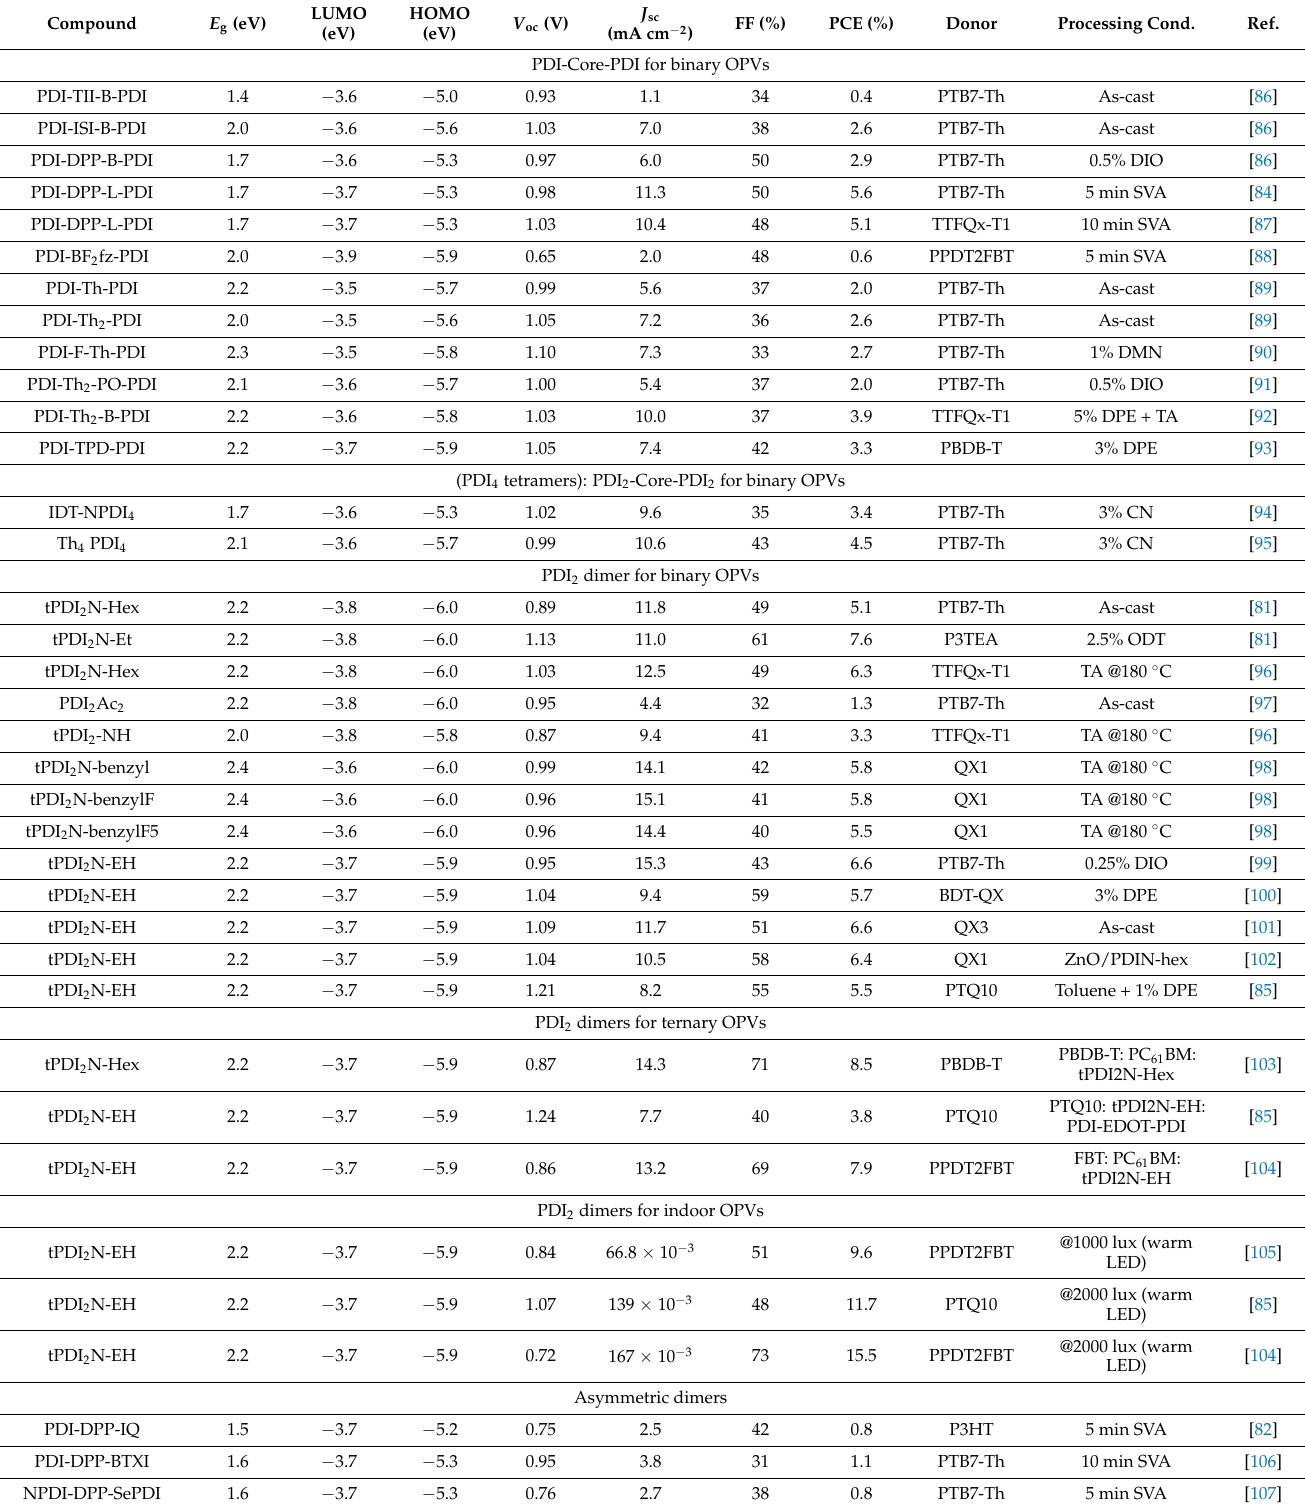
Table 1. Summary of the optoelectronic properties of PDI-Core-PDI dimers, PDI 4 tetramers, PDI 2 dimers, and asymmetric PDIs and the corresponding photovoltaic characteristics based on BHJ OPV